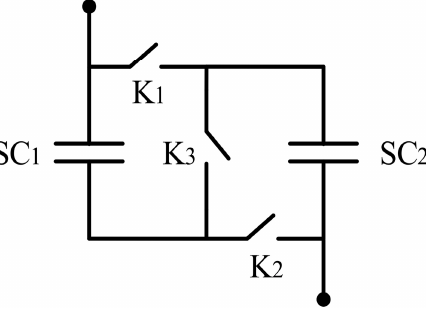
Figure 4. Basic switching cell SCB for two supercapacitors.